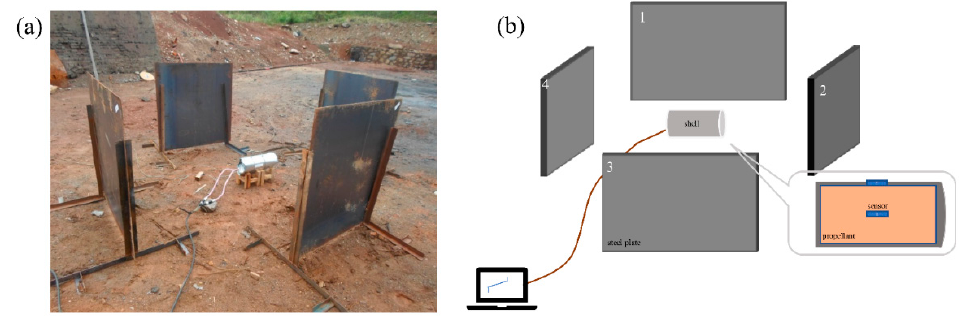
Figure 2. ( a ) The scaled-down solid engine slow cook-off device diagram and ( b ) schematic dia-